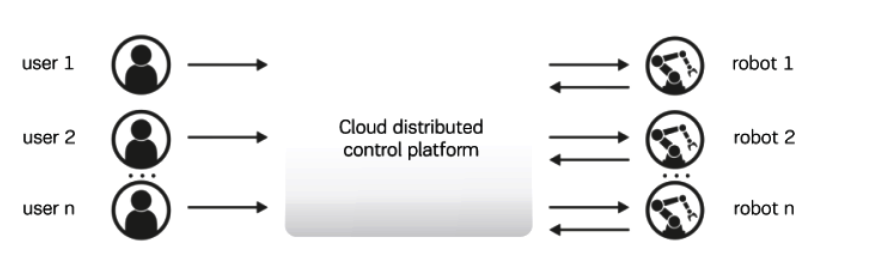
Figure 1. The scheme of the problem: on the left side there is a variety of users connecting to the cloud robotic control platform with a thin client (mobile device, laptop, etc.); in the center, there is a cloud distributed control platform organized (in a common case) as a set of web-servers distributed across the world, balancing the traffic load and providing the simultaneous access for users to the robotic control web-services, the back-end of the control platform also performs heavy computations for the robots such as assessing the robot‘s environment with the computer vision techniques and automatic feedback-based correction of the robots parameters; the right part of the picture is a set of robots performing the operations under the control of the users from the left side, the communication between the user and the robot is done with the cloud distributed control